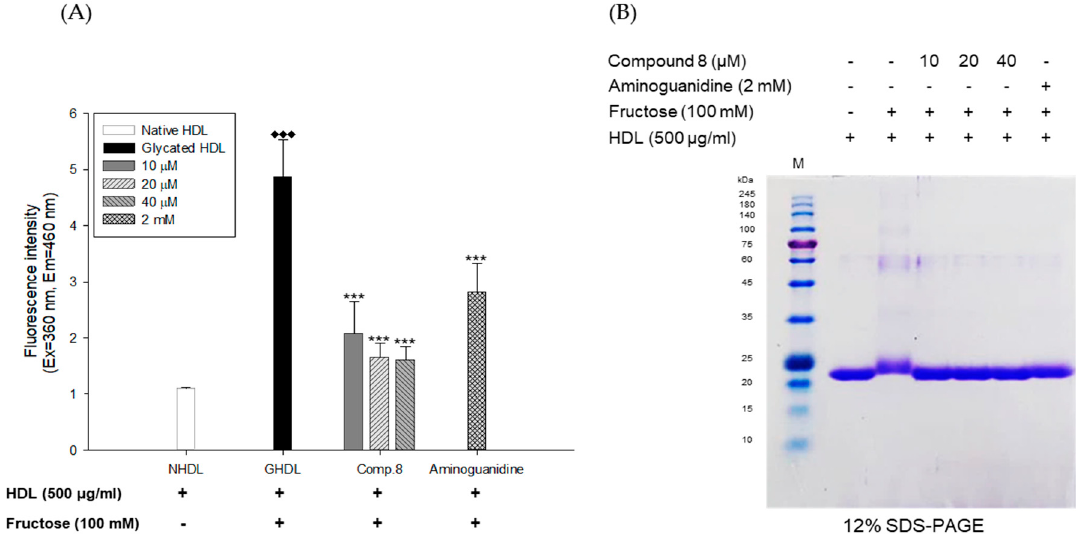
Figure 7. Dose dependent effect of compound 8 (des- O -methyl- β -anhydroicaritin) on fructose- induced HDL glycation. ( A ) formation of AGEs was determined by measuring the fluorescence intensity (Ex = 360 nm, Em = 460 nm). ( B ) SDS-PAGE of HDL modified by 100 mM fructose for 72 h in the absence or presence of compound 8 (final concentrations, 10, 20, and 40 μ M). These data are expressed as mean ± SD of three independent experiments. ♦♦♦ , p < 0.001 vs. NHDL (native HDL); ***, p < 0.001 vs. GHDL (glycated HDL).